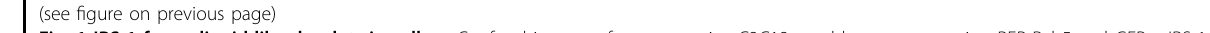
Fig. 1 IRS-1 forms liquid-like droplets in cells. a Confocal images of representative C2C12 myoblasts co-expressing RFP-Rab5 and GFP-mIRS-1. Scale bar, 10 µm. b Rendered 3D shapes of an mIRS-1 droplet. The panels show the XY, XZ, and YZ planes. Scale bar, 1 µm. c A plot showing the sphericity of mIRS-1 droplets ( n = 270). The quanti fi cation result is shown as mean ± SEM. d Protein sequence and disorder prediction (PONDR) of the mIRS-1 [1233 amino acids (aa)]. e Representative images of mIRS-1 droplets in C2C12 cells expressing either GFP-tagged mIRS-1, PH-PTB region (1-300 amino acids), or mIRS-1 IDR (301 – 1233 amino acids). Scale bar, 10 µm. f Immunoblot analysis of IRS-1 expression levels in C2C12 wildtype, uninduced or DOX-induced C2C12-IRS-1 KO/GFP-mIRS-1 cell line. g Confocal images of GFP-mIRS-1 in uninduced or DOX-induced C2C12-IRS-1 KO/GFP-mIRS- 1 cells. h Rendered 3D shapes of an mIRS-1 droplet in DOX-induced C2C12-IRS-1 KO/GFP-mIRS-1 cells and a plot showing the sphericity of mIRS-1 droplets ( n = 233). Scale bar, 1 µm. Data are shown as mean ± SEM. i Correlative light-electron microscopy (CL-EM) of C2C12 cells transiently transfected with GFP-mIRS-1. Scale bar, 10 µm. The upper panel insert shows three GFP-mIRS-1 foci and the lower panel inserts show three membrane-less mIRS-1 bodies. j Time-lapse imaging showing fusion of two mIRS-1 droplets in DOX-induced C2C12-IRS-1 KO/GFP-mIRS-1 cells. Scale bar, 10 µm. k Confocal images and quanti fi cation of mIRS-1 fl uorescence recovery after photobleaching in DOX-induced C2C12-IRS-1 KO/GFP-mIRS- 1 cells. Scale bar, 10 µm. Right panel: quanti fi cation of fl uorescence intensity recovery of photobleached IRS-1 bodies ( n = 11). Data are shown as means ±